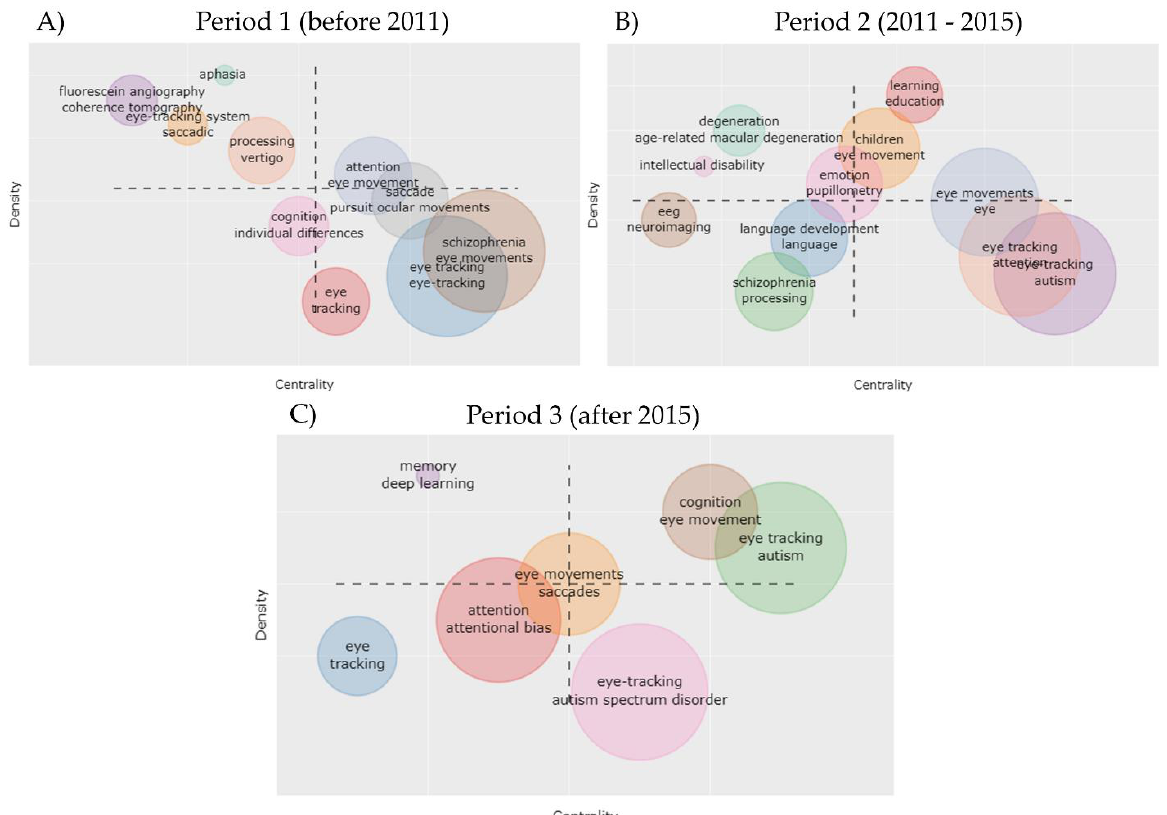
Figure 5. Thematic evolution of eye tracking studies. A thematic map is constructed via the application of a clustering algorithm on the network of keywords of the retrieved articles. Thematic networks are plotted in two dimensions, where axes are the function of centrality (the importance of the theme in the research field, horizontal axis) and density (a measure of the theme’s development, vertical axis) of the thematic network. Three time slices are represented: ( A ) Period 1: before 2011; ( B ) Period 2: 2011–2015; and ( C ) Period 3: after 2015. For each period, the left upper quadrant (high density and low centrality) shows highly developed and isolated themes (niches), the right upper quadrant (high density and high centrality) shows motor themes, the left lower quadrant (low density and low centrality) shows emerging or declining themes and the right lower quadrant (low density and high centrality) shows basic and transversal themes. Each bubble represents a cluster of topics (colors indicate different clusters). The name of the two topics with higher occurrence is shown in the bubble. The size of the bubble is proportional to the cluster word occurrences, while the bubble position is set according to the cluster centrality and density.